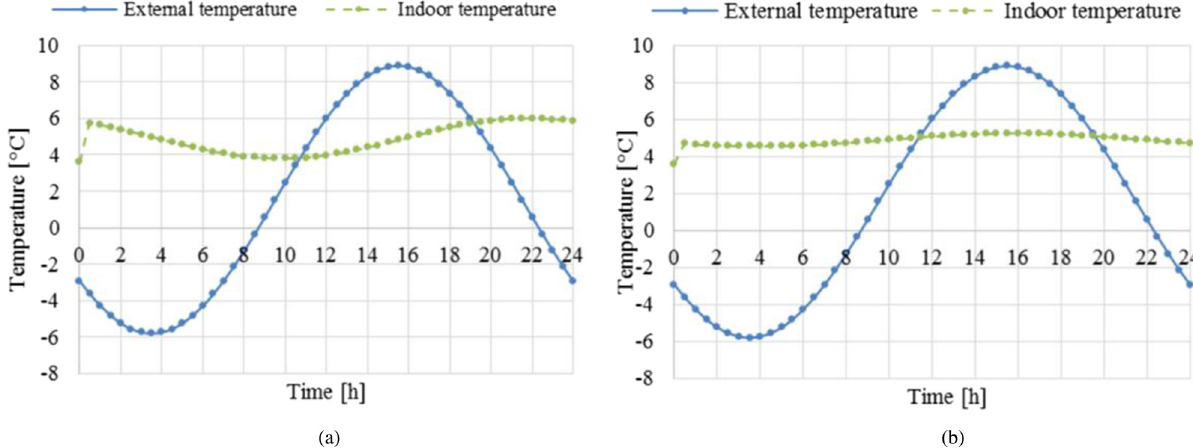
Fig. 8. Variation of indoor temperature depending on the placement of the insulation. (a) Inside insulation and outside thermal mass. (b) Outside insulation and inside